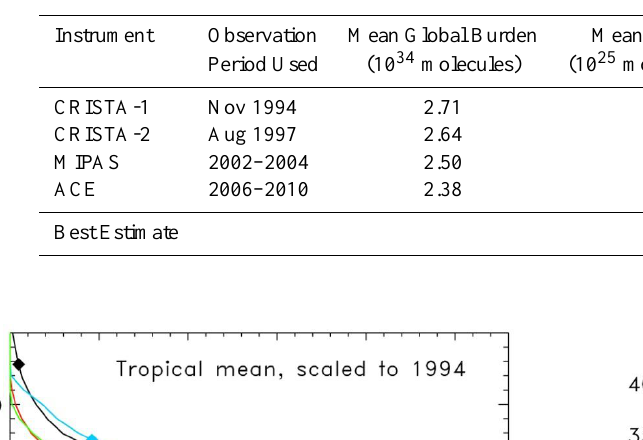
Table 1. CFC-11 lifetimes based on global satellite observations.